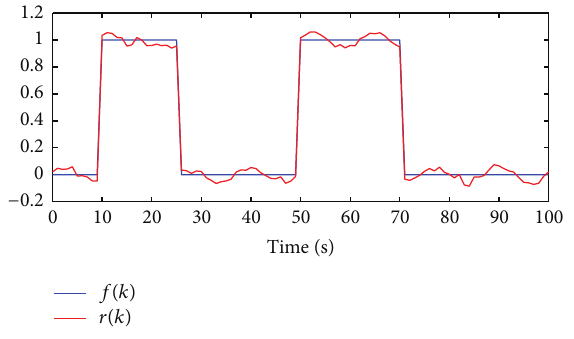
Figure 1: Fault and its